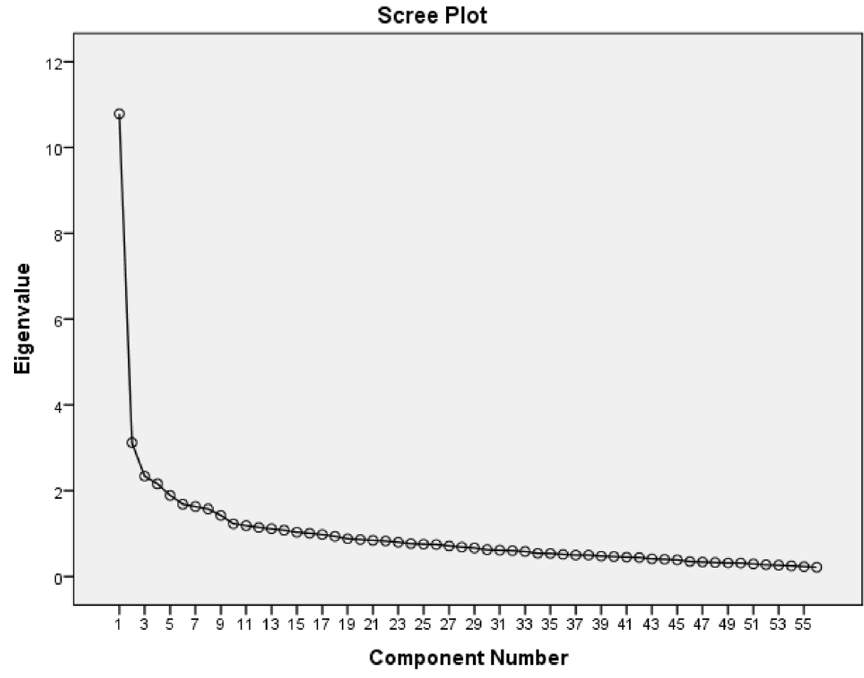
Fig. 1 Scree plot of the sources of unreliability of a test scale items